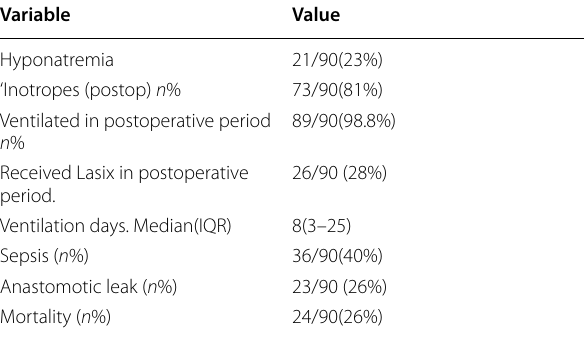
Table 2 Postoperative characteristics of the